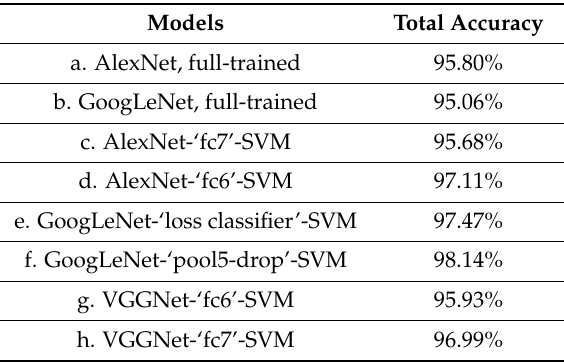
Table 1. The obtained values for the total accuracy of the eight transferred CNN-based models, where training and testing datasets were kept the same for each